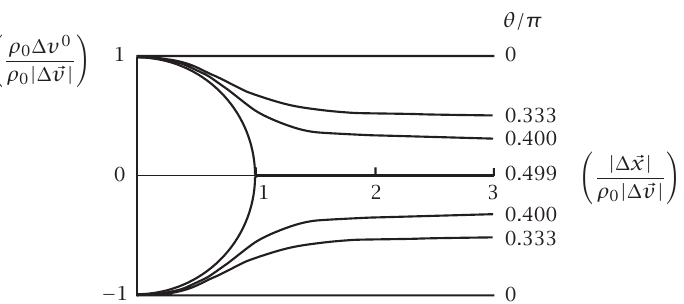
∆ v 0 /ρ | ∆ (cid:11)v | ) as a 0 0